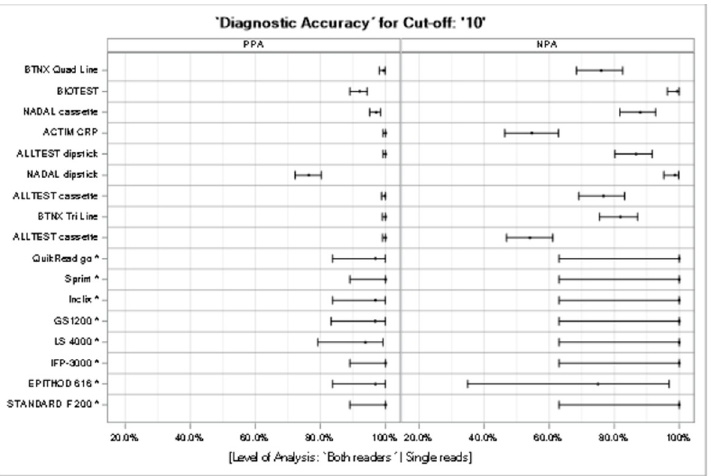
Fig 5. PPA and NPA for semi-quantitative and quantitative tests (cut-off: 10 mg/L). For a cut-off of 10 mg/L, which was available for all quantitative and semi-quantitative methods, the binary test results were assessed; thus, the positive and negative percent agreement were estimated, together with their 95%-Pearson Clopper